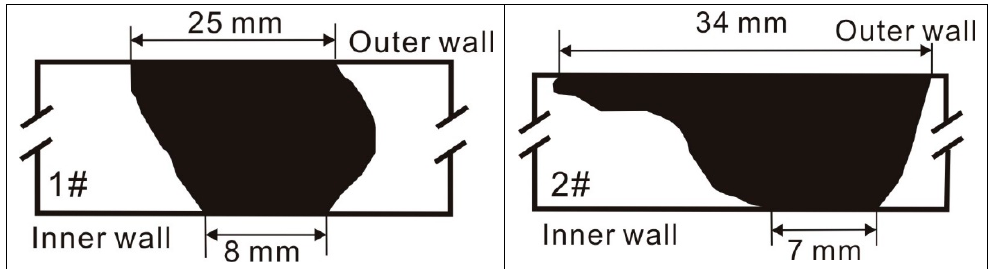
Figure 7. Restoration diagram of original fracture of leaking pipe.